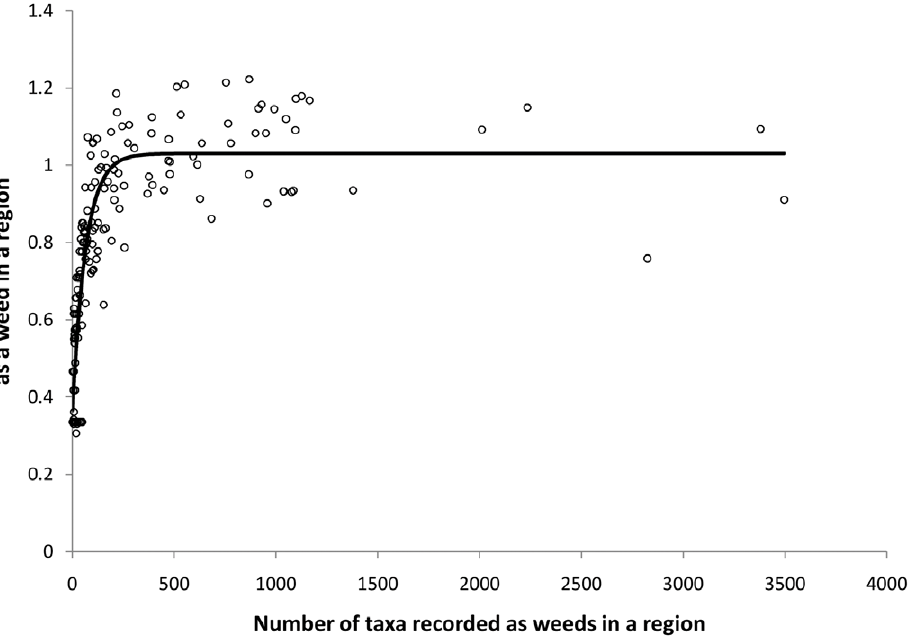
Figure 2. A region’s weed taxa and SOM index of the highest ranked taxon. Relationship between the number of taxa recorded as weed in a region (arc sine transformed) and the SOM index (i.e. likelihood of becoming a weed) for the highest ranked taxon that is currently not recorded as a weed in that region.